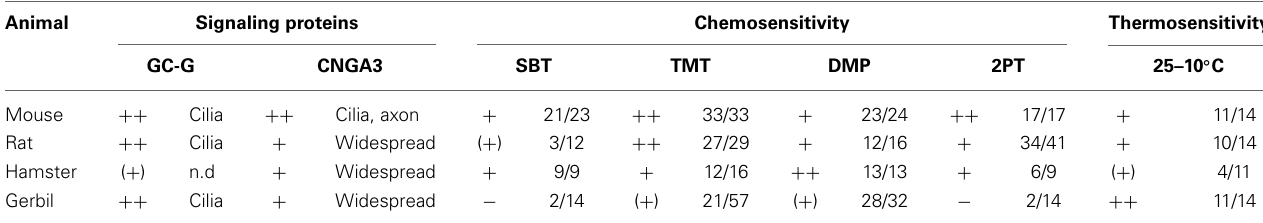
Table 2 | Physiological properties of the rodent